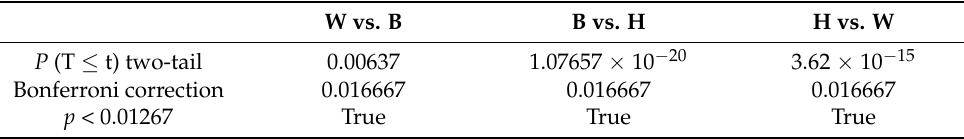
Table 3. Post-hoc test with respect to race and